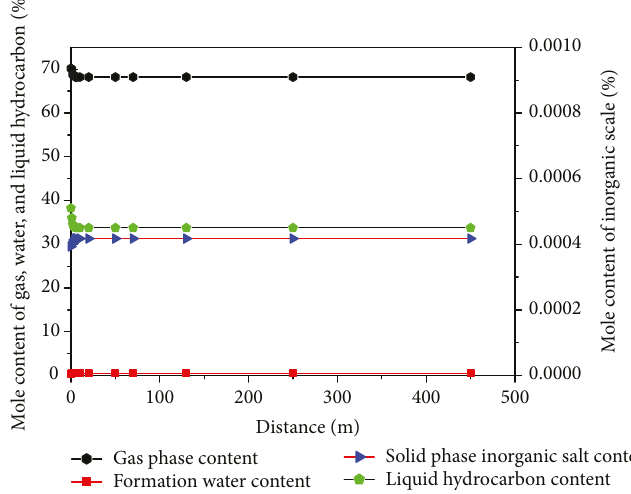
Figure 9: Phase distribution of BS8 fl uid in formation.